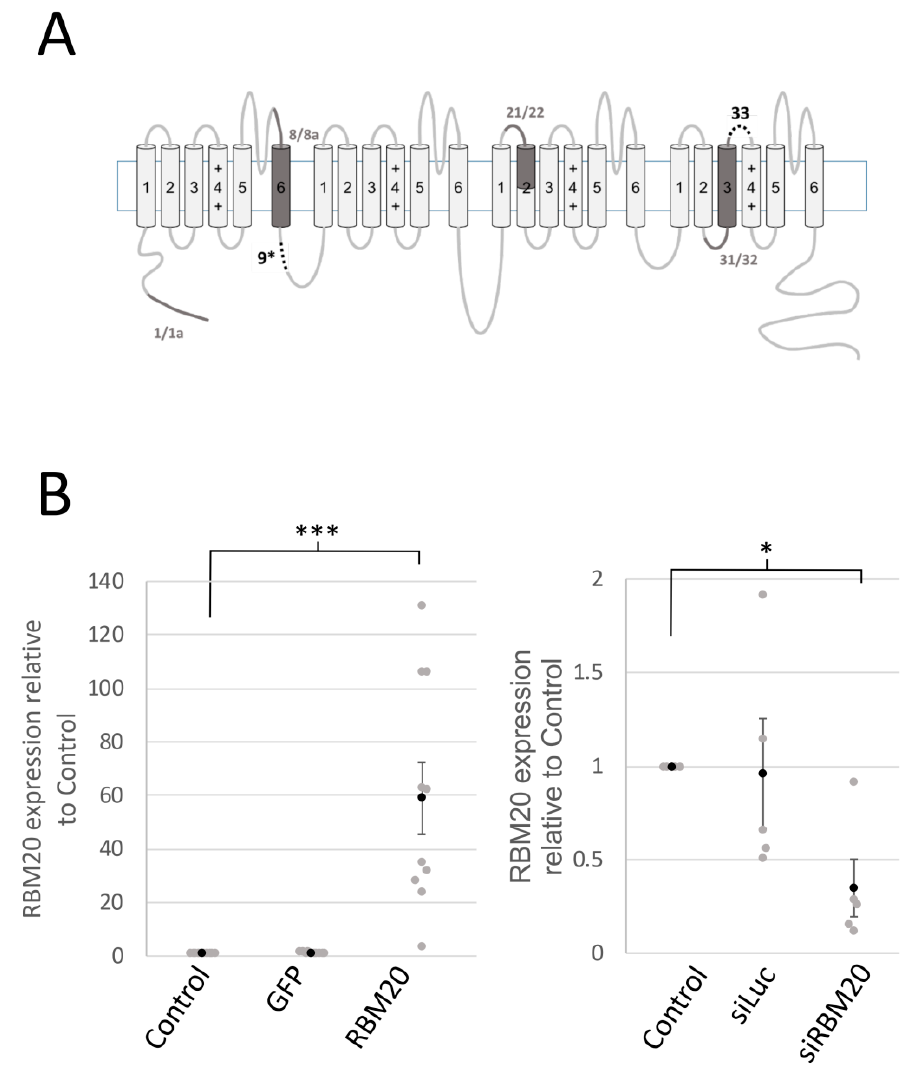
Figure 1. The splicing factor RNA-binding motif 20 (RBM20) regulates the inclusion of alternatively spliced exon 9*. ( A ) The scheme represents the α 1C subunit of l -type voltage calcium channels. CaV1.2 ( α 1C) is composed of four homologous regions consisting of six transmembrane domains (S1–S6) that form the pore of the channel. ( + ) indicates voltage sensors on S4. There are two types of alternatively spliced exons on CaV1.2: [1] Mutually exclusive exons—1 / 1a, 8 / 8a, 21 / 22, and 31 / 32 (the corresponding region is shown in dark)—and [2] optional exons—9* and 33 (shown as dotted lines). ( B ) The graphs show RBM20 expression measured by quatitative RT-PCR. The left graph is the expression of RBM20 measured in the control, Green Fluorescent protein (GFP)-overexpressing, and RBM20-overexpressing cardiomyocytes. Data are the mean and SEM (black circle) of n = 10 total RNA extracts from 10 cardiomyocyte isolations (gray circle). The right graph shows the expression in the control, luciferase-1-targeting siRNA (siLuc) tranfected cardiomyocytes, and siRNA-targeting RBM20-overexpressing cardiomyocytes. Data are the mean and SEM (black circle) of n = 5 total RNA extracts from 5 cardiomyocyte isolations (gray circle). * means p < 0.05 and *** p < 0.001.